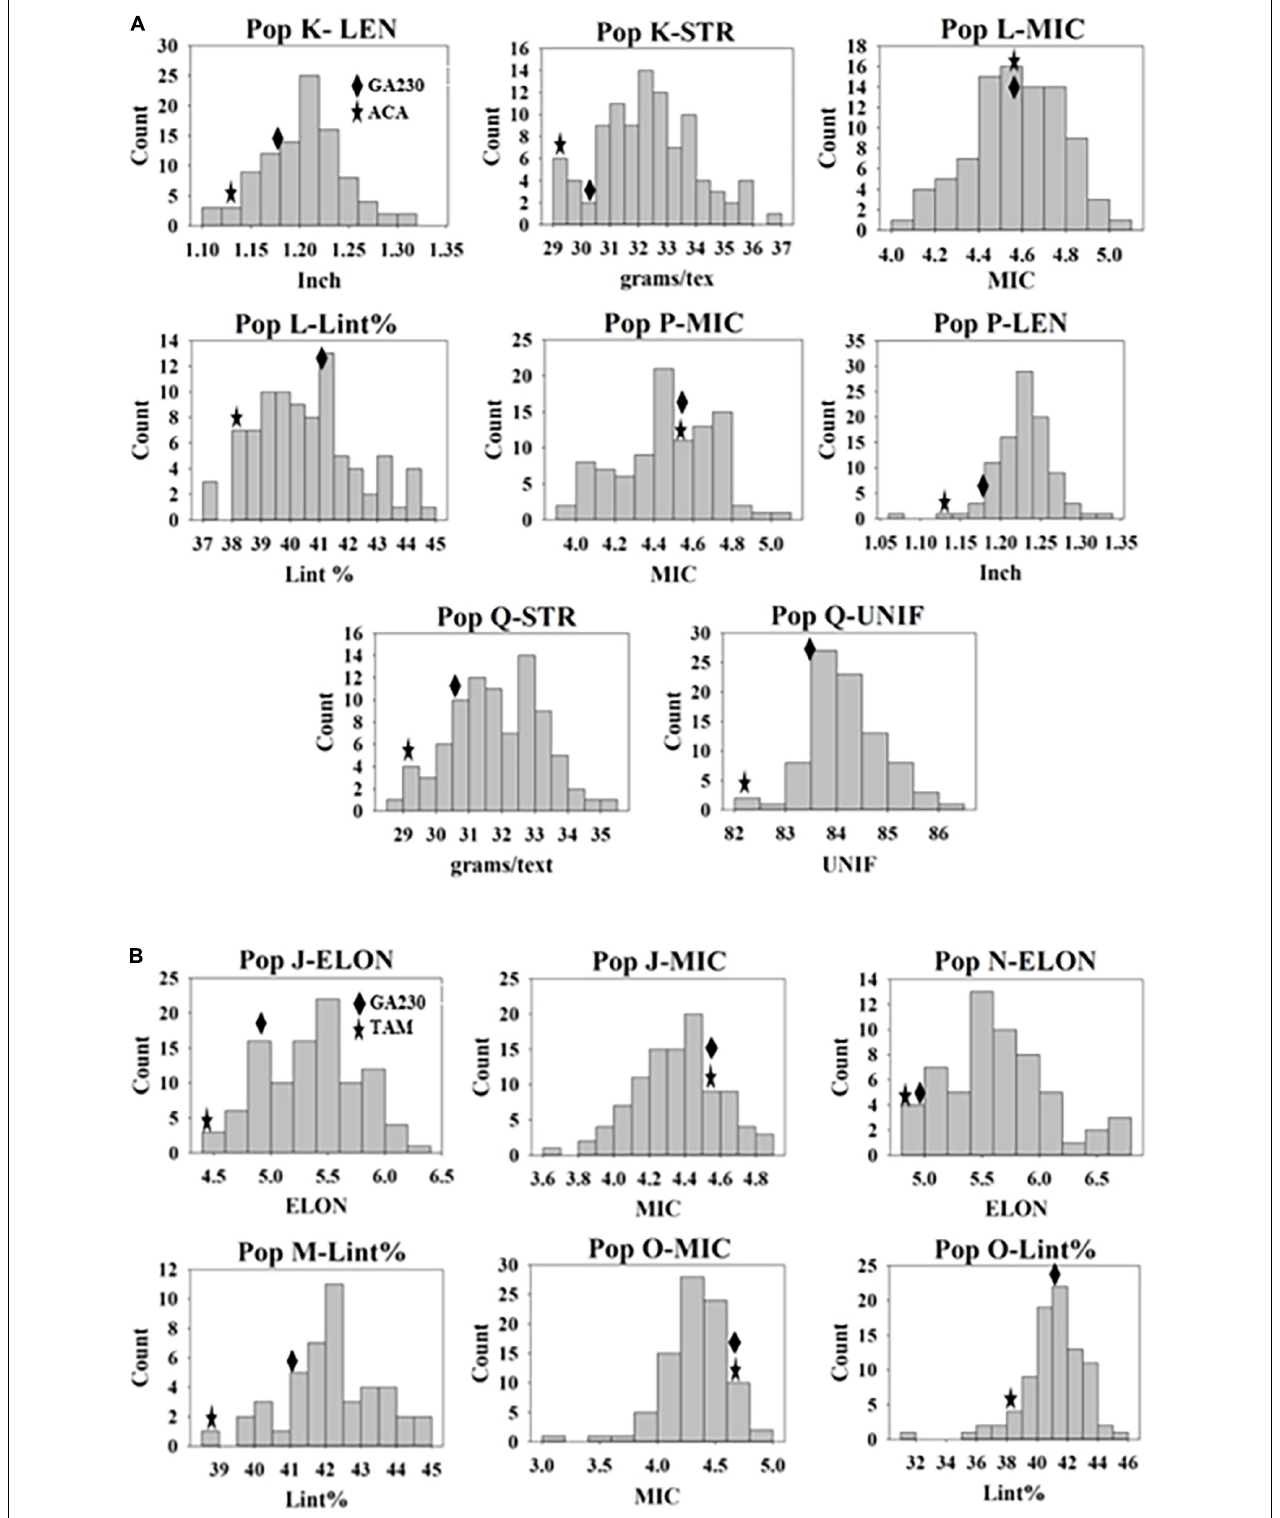
FIGURE 2 | Distribution of genotypes in populations for fiber traits they were developed. (A) Populations from Acala 1517-99 (mutant) × GA230. (B) Populations from TAM 94L25 (mutant) × GA230. Mean values of M0 parents and GA230 from the data of three environments are indicated on the distribution graph.